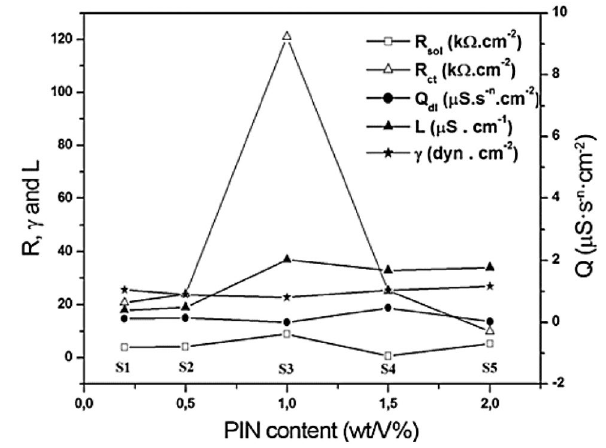
Fig. 10 Relationship of PIN concentration with surface tension ( γ ) and solution conductivity (L) double layer capacitance (Qdl)